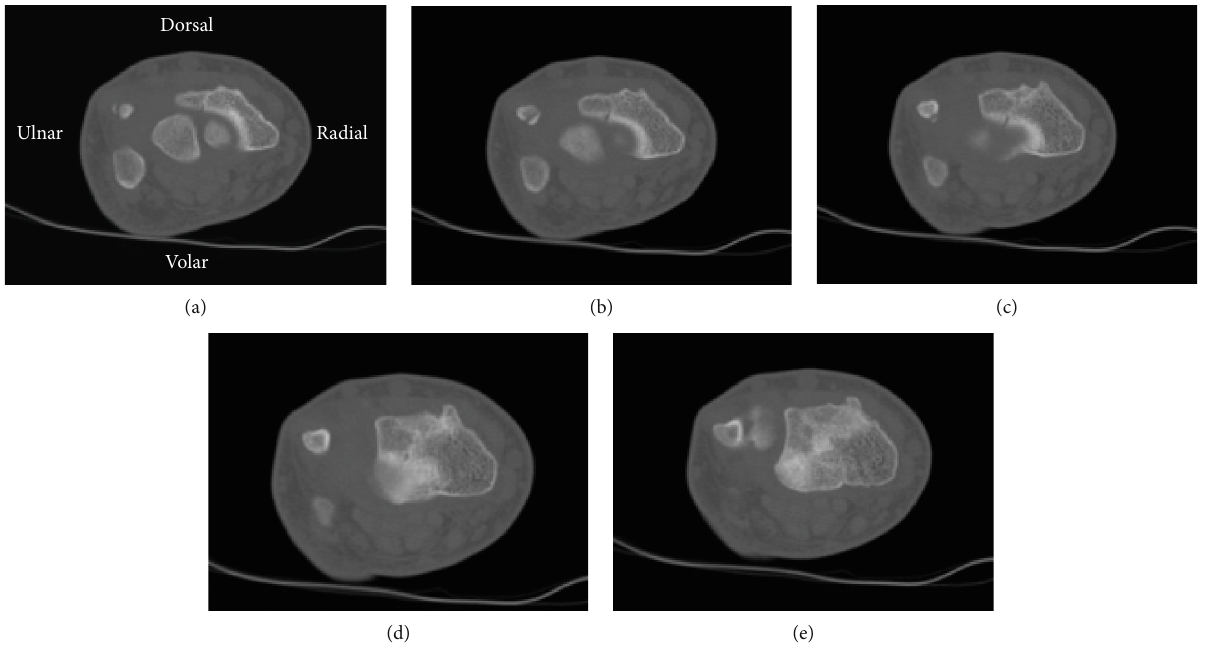
Figure 2: Sequential axial CT views (proximal to distal) demonstrating intra-articular extent of the fracture through the dorsal rim of the radial physis. (d) Shows the radial epiphysis fully in view, revealing the most volar extent of the fracture line dorsal to the volar ulnar